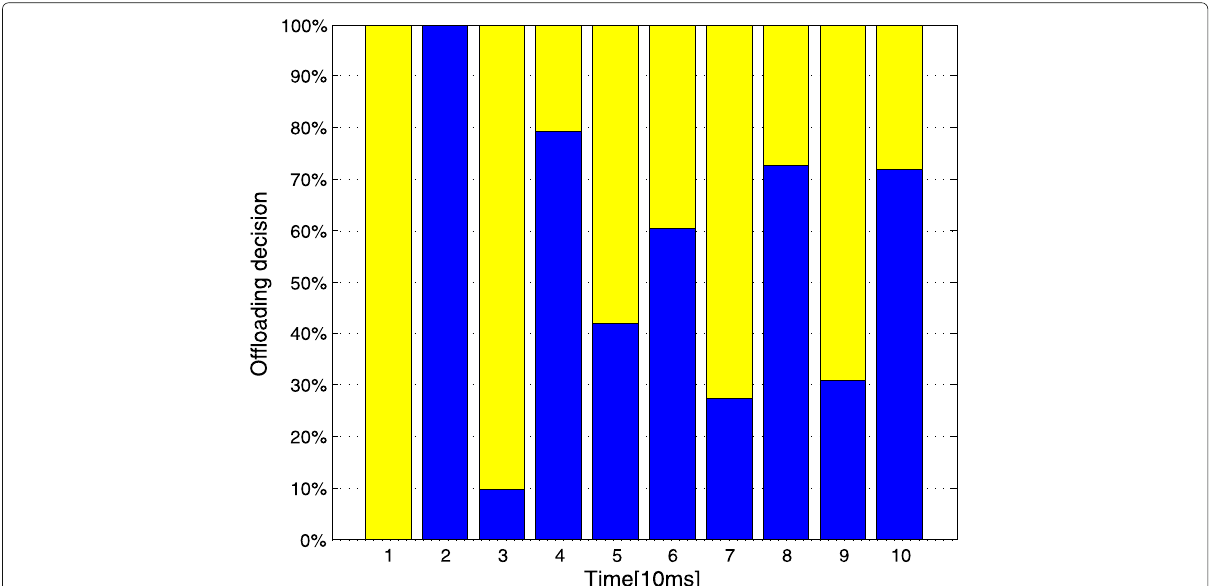
Fig. 10 The task offloading decisions of vehicle k n at different time